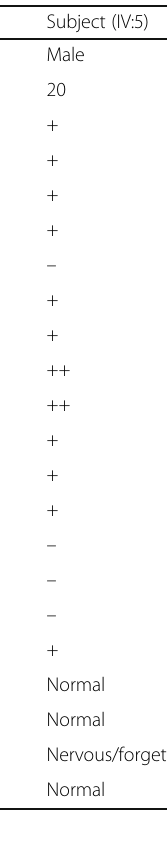
Table 1 Clinical features of the affected individuals